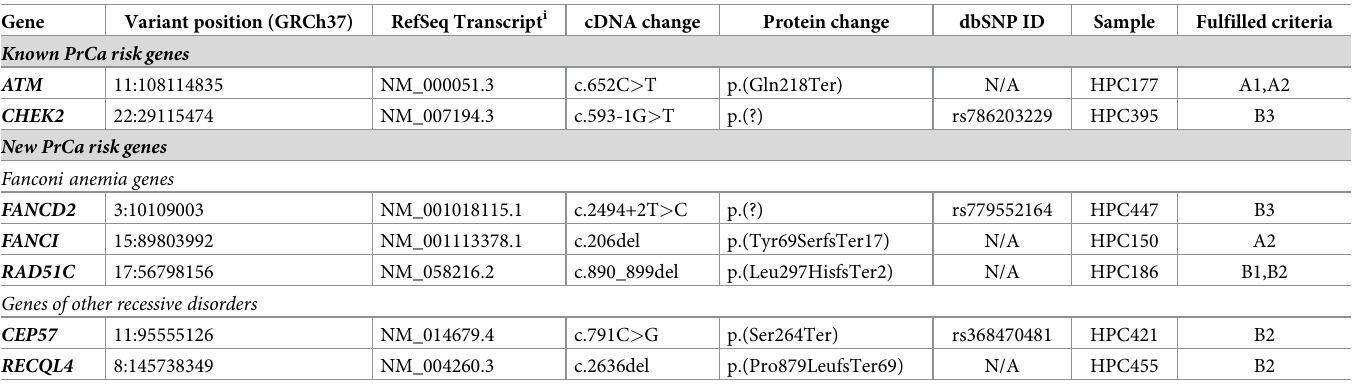
Table 1. Truncating/Deleterious mutations found in the 121 cases by targeted NGS